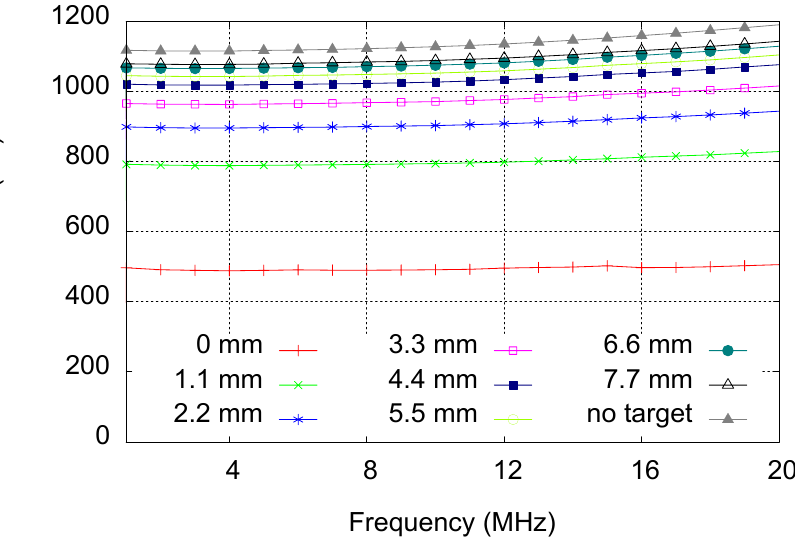
Figure 9. Measured inductance of the sensing